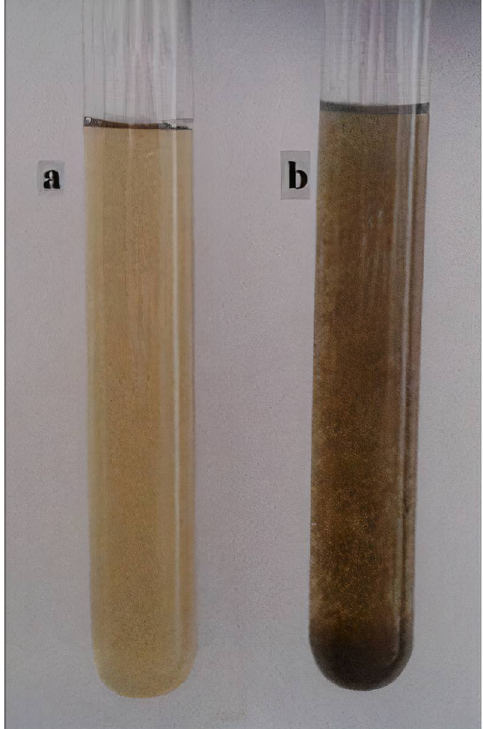
Figure 2. ( a ) Thymus vulgaris leaf extract and ( b ) solution after green synthesis of CuO nanoparticles. Adapted with permission from Ref. [85]. 2016,